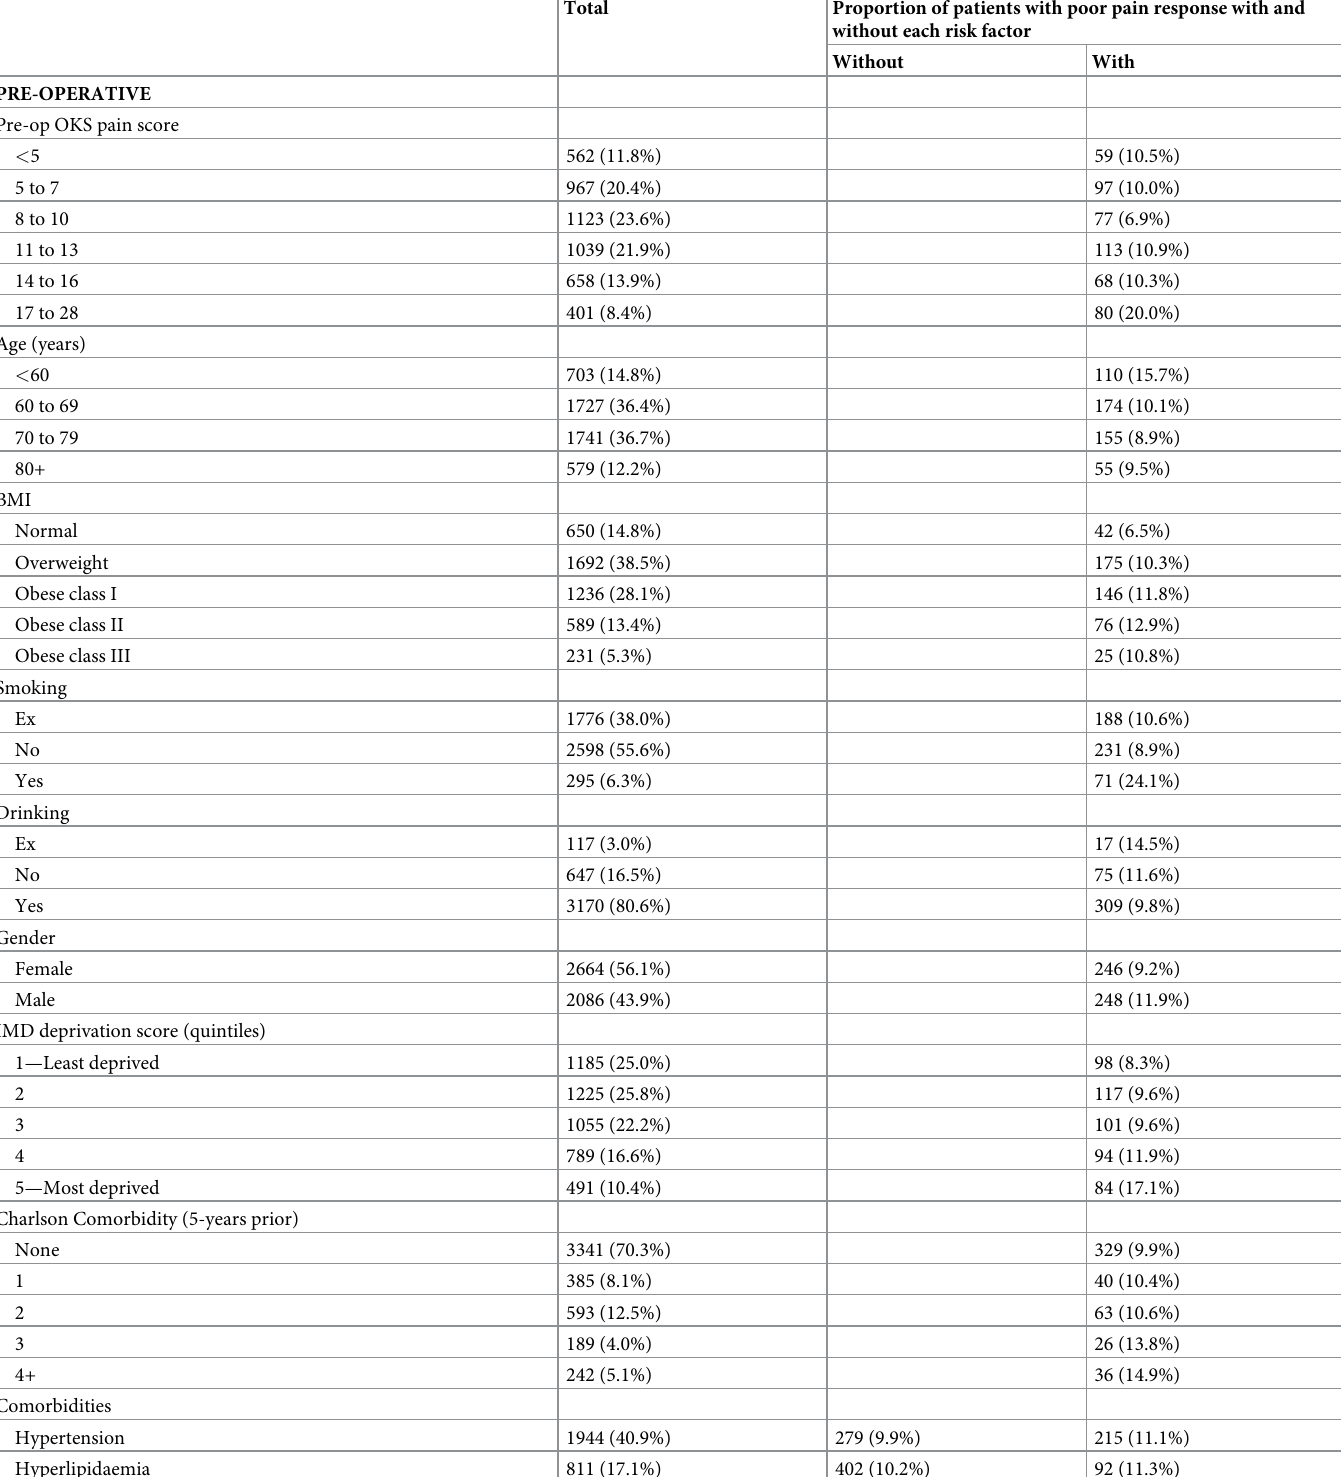
Table 1. Descriptive statistics describing the total number of patients with each potential risk factor, and the proportion of patients with a poor pain outcome, according to whether or not they have the factor. Total Proportion of patients with poor pain response with and without each risk factor Without